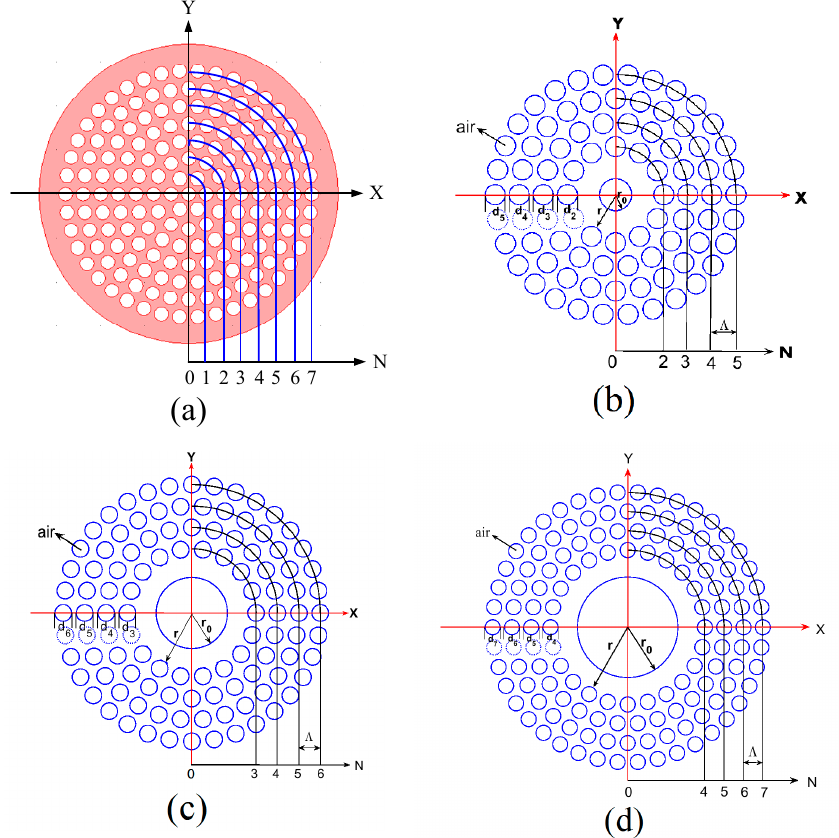
Figure 4. Cross-section and main parameters of the designed circular photonic crystal fibers (C-PCFs) for ( a ) the fiber base; ( b ) C-PCF 1#; ( c ) C-PCF 2#; and ( d ) C-PCF 3#. Reprinted from [45] by permission from